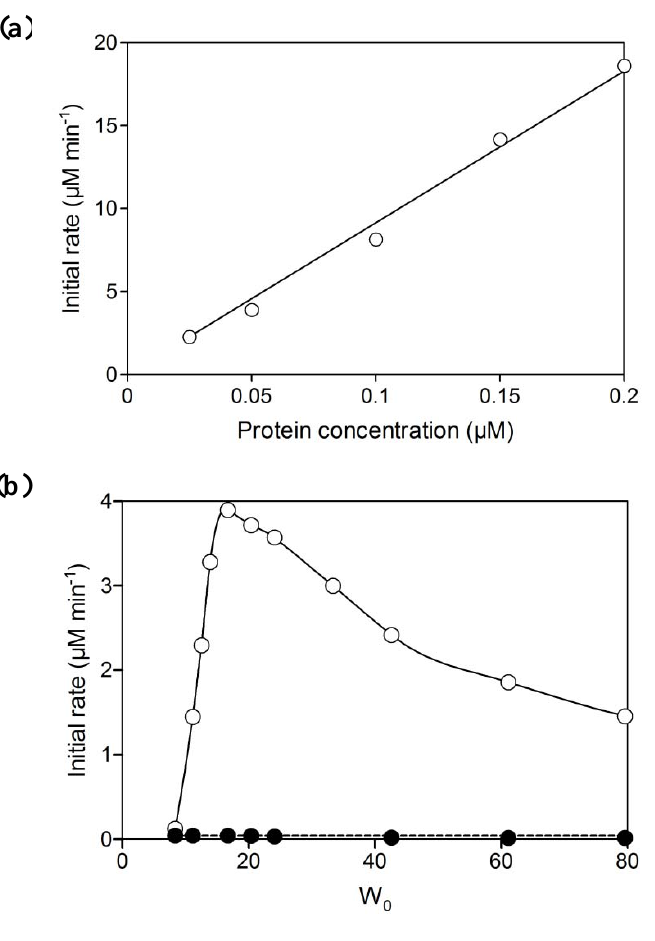
Figure 2. (a) Relationship between the initial rate of NADH oxidation and the concentration of branched P450cam at a water content (W contained 5 mM d -camphor and 80 μ M NADH. (b) Effect of W branched P450cam (open circles) and an equimolar mixture of PdR, PdX and P450cam (closed circles). The reaction mixtures contained 0.05 μ M protein, 5 mM d-camphor and 80 μ M NADH. The reversed micelle solution containing PdR, PdX and P450cam was prepared by adding a mixture of PdR, PdX and P450cam to a starter reversed micelle solution (see experimental